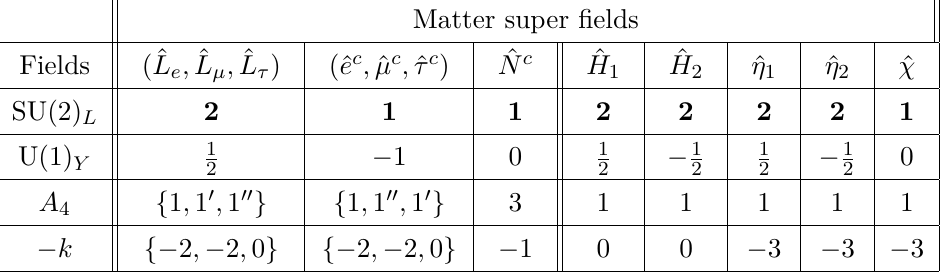
Table 1 . Matter chiral superfields and their charge assignments under SU(2) L × U(1) Y × A 4 , where − k is the number of modular